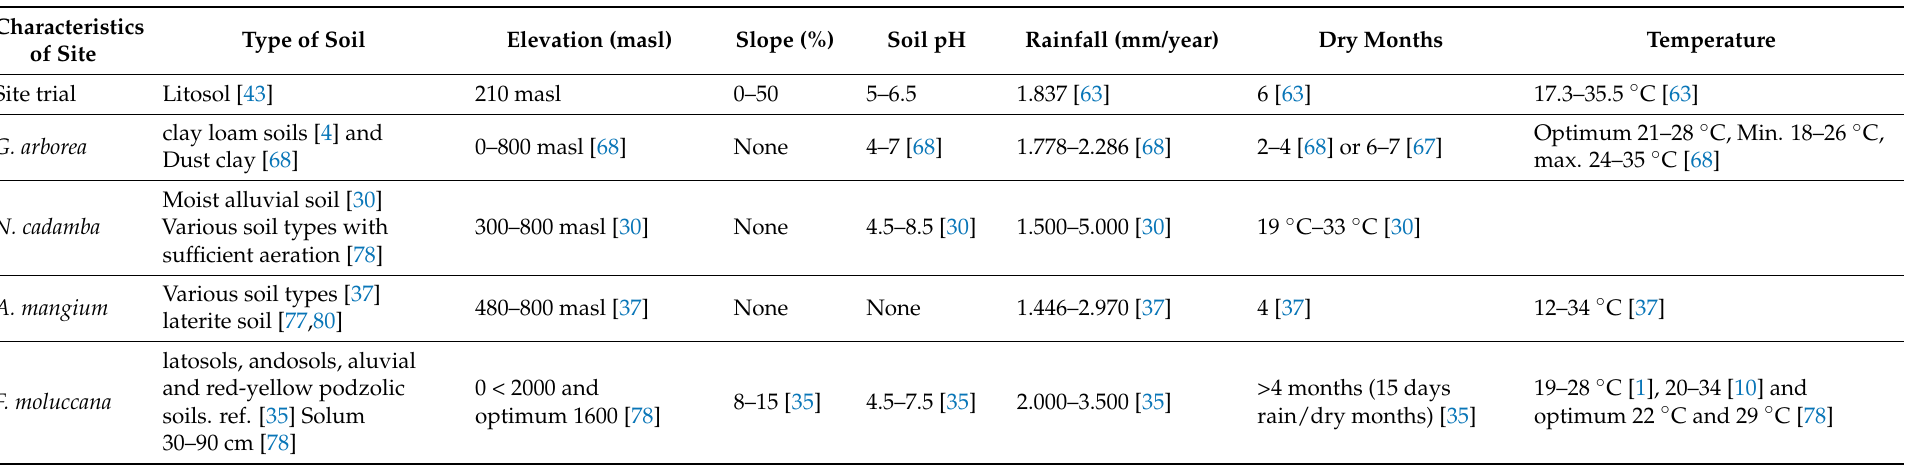
Table 3. Requirement of physical environmental conditions for the growth of four